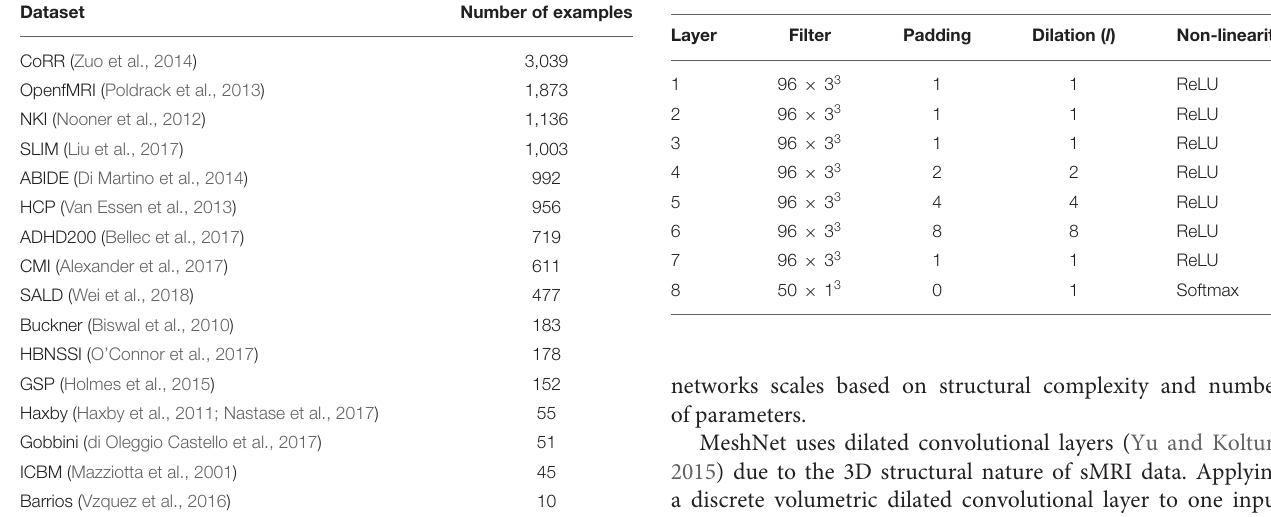
TABLE 2 | The MeshNet dilated convolutional neural network architecture used for brain segmentation. Layer Filter Padding Dilation ( l